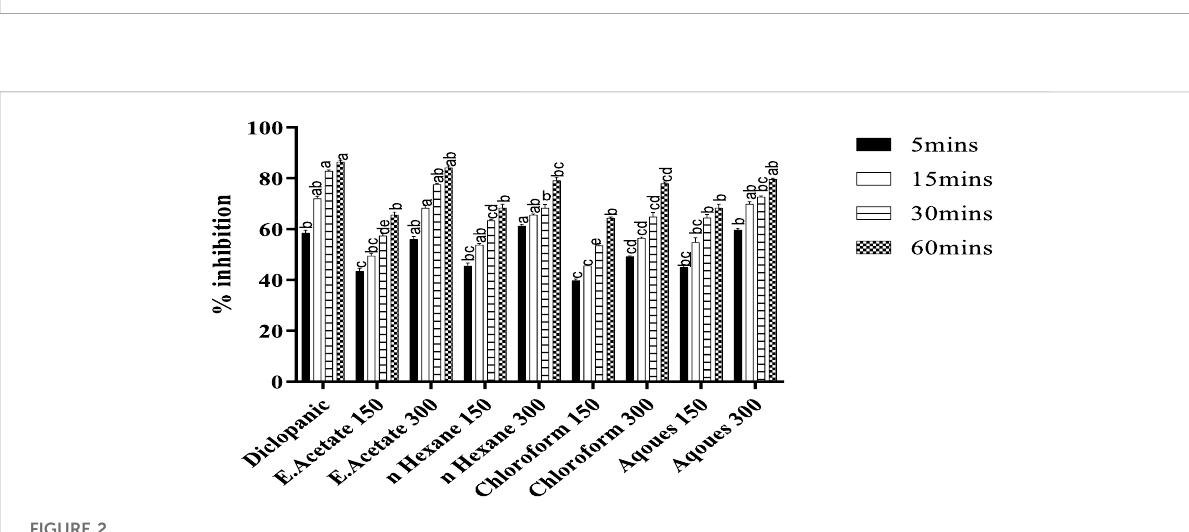
FIGURE 2 Analgesicactivityof Justiciaadhatoda ’ sdifferentfractionswasmonitoredatthedoseof150and300 mg/kginaceticacid-inducedSwissalbino mice. Different statistical bars represent statistical differences at p <